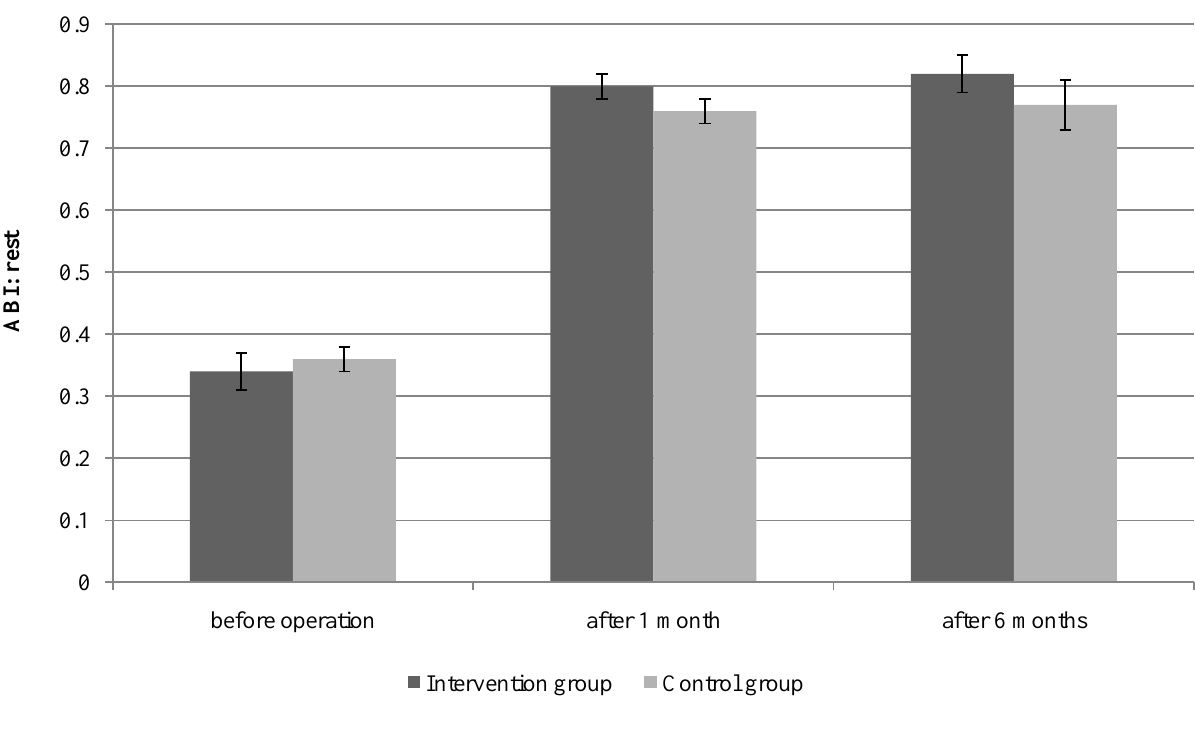
Figure 4. Peripheral hemodynamic measurements at baseline, at 1 and 6 months after the surgery in the intervention (n = 57) and control groups (n = 60). ABI = ankle-brachial index; error bars indicate ± standard error; months = after bypass surgery.